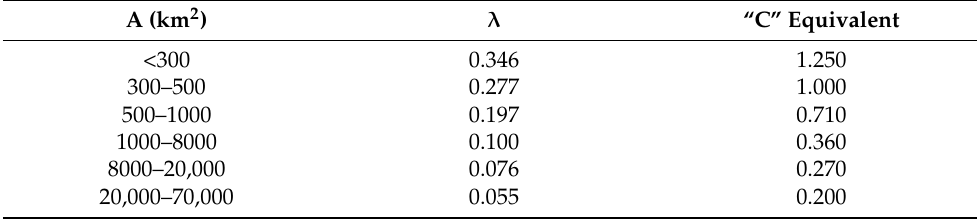
Table A3. Giandotti reduction coefficients (Source: